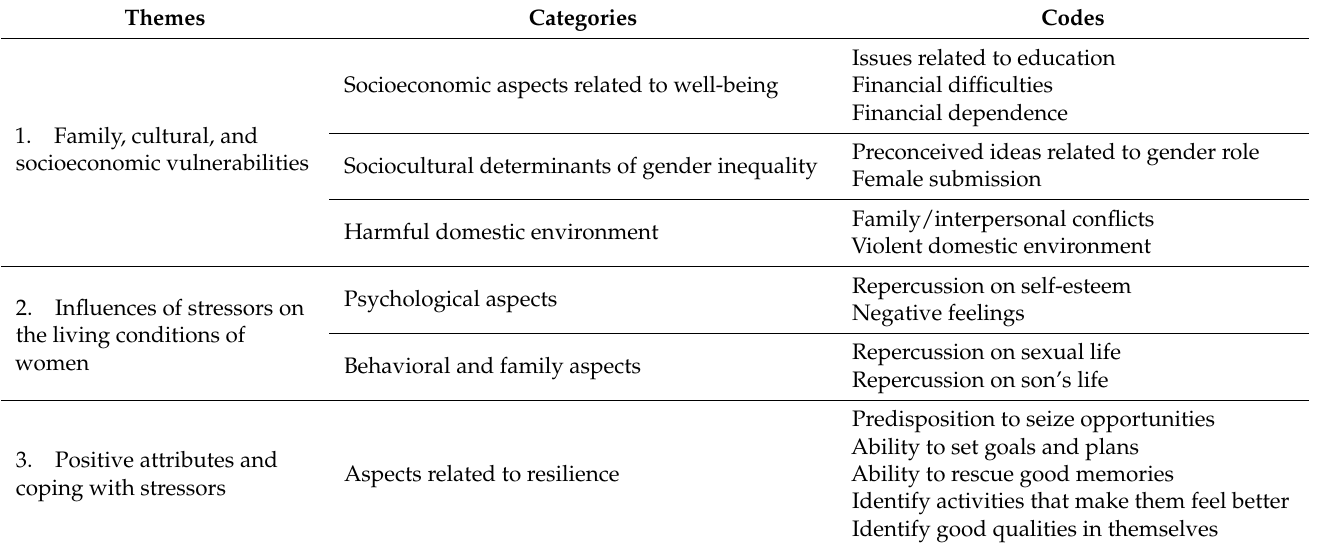
Table 1. Themes, categories, and codes from data